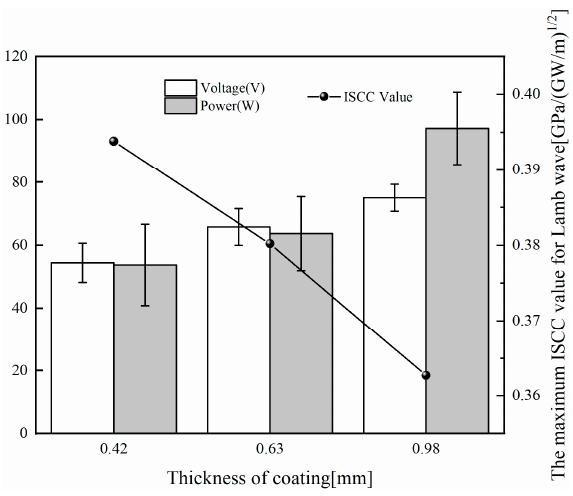
Figure 17. De-icing voltage, power, and the maximum ISCC value for coatings with di ff erent thicknesses